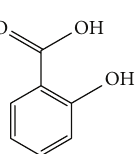
Figure 1: Chemical structures of salicylic